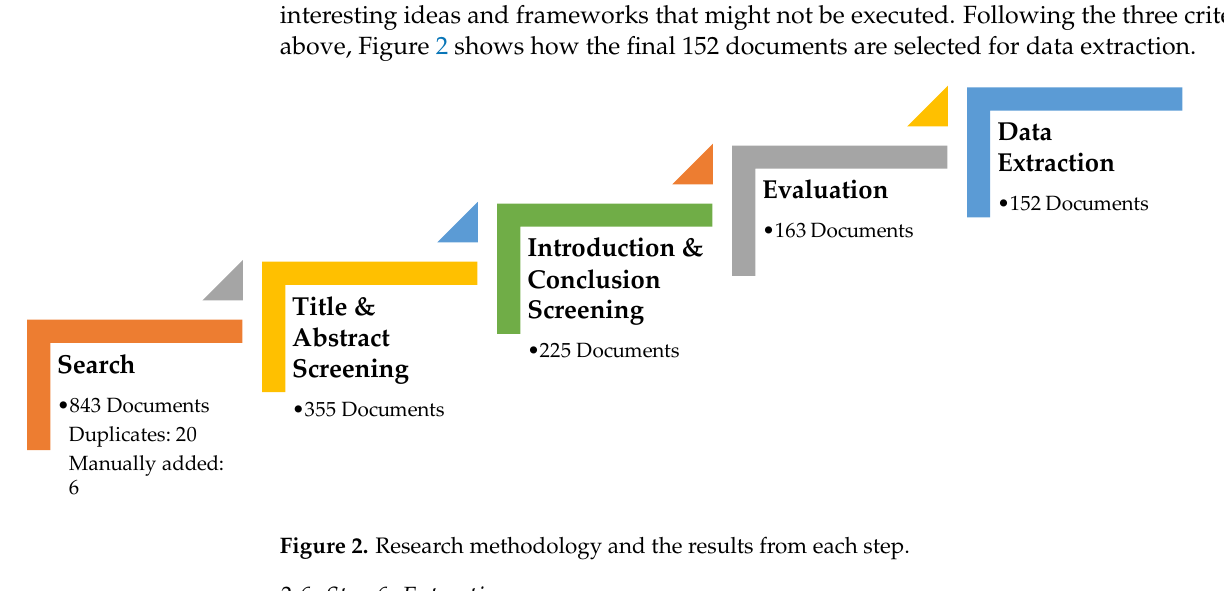
Figure 2. Research methodology and the results from each step .